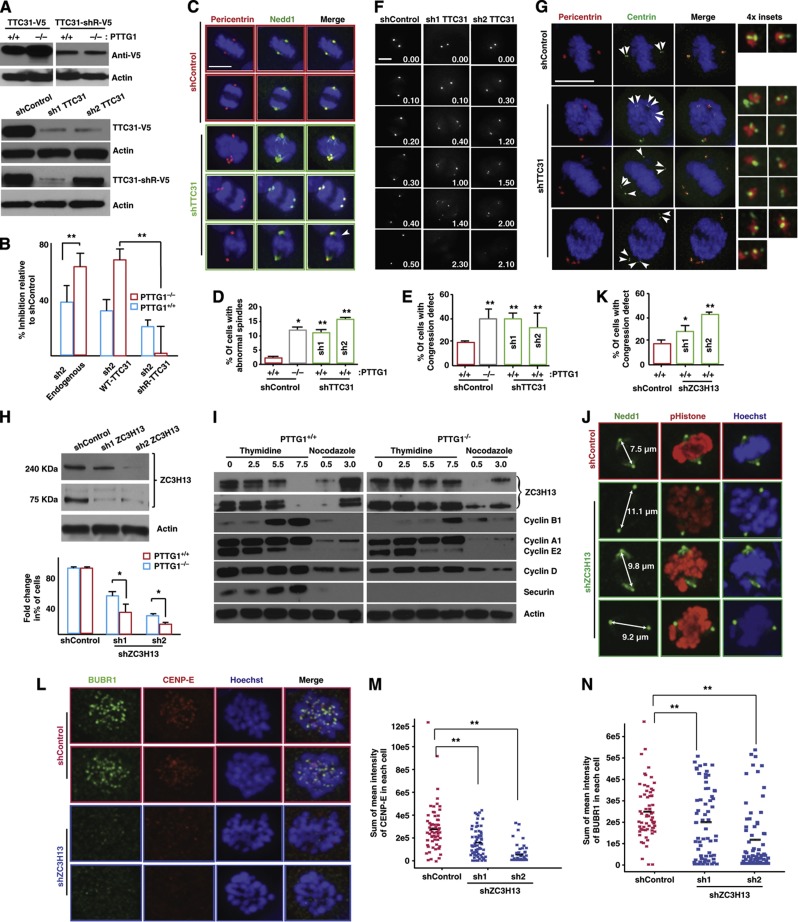
Functional discovery based on genetic interactions. (A) Top panels shows the western blot of total cell lysates expressing both wild-type (TTC31-V5) and shRNA-resistant (TTC31-shR-V5) TTC31 protein tagged with V5 in PTTG1−/− and PTTG1+/+ cell lines. The bottom panel shows the effect of two independent shRNAs in TTC31-V5 and TTC31-shR-V5. TTC31 was knocked down by infecting HCT116 cells with two independent hairpins targeting TTC31, followed by a western blot with anti-V5 antibody to confirm on-target knockdown. (B) Rescue experiment showing the on-target effect of sh2-TTC31 as evaluated by the percentage inhibition in growth WT-TTC31-expressing cells relative to shR-TTC31-expressing cells. (C) Immunofluorescence microscopy images of PTTG1+/+ cells expressing control shLacZ (top) or sh2-TTC31 (bottom). Centrosomes are indicated by pericentrin (red) and NEDD1 (green) staining, and the nucleus was detected with DAPI (blue). Arrowheads indicate lagging chromosomes. (D and E) Quantification of cells with abnormal spindle morphology and cells with congression defects was performed by analyzing at least 100 cells (n=3). **P-value<0.01 calculated using χ2-test. Scale bar, 4 μm. (F) Time-lapse imaging of HeLa cells stably expressing the centrosome marker NEDD1-GFP. Cells were either infected with the negative control shRNA targeting LacZ or with two independent shRNAs against TTC31 (sh1- or sh2-TTC31). Frames taken at the indicated time points (h:min) relative to entry into mitosis are shown. Scale bar, 10 μm. (G) Localization of centrin structures in PTTG1+/+ cells expressing shLacZ control or one of two independent shRNAs against TTC31 (sh1- or sh2-TTC31). DNA and centrosomes were labeled as in C. Representative prometaphase, metaphase and anaphase cells with supernumerary centriole phenotypes are shown. Insets are fourfold magnifications of centrosomal regions. Scale bar, 10 μm. (H) Top panels shows the western blot of total cell lysates expressing two isoforms of ZC3H13 in PTTG1+/+ cells. ZC3H13 was knocked down by infecting HCT116 cells with two independent hairpins (sh1- and sh2-ZC3H13) and followed by western blot with an anti-ZC3H13 antibody (Abcam). The bottom panel shows the negative genetic interaction of two independent shRNAs as assessed by proliferation. (I) Western blot analysis of whole-cell lysates showing the cell cycle-dependant regulation of ZC3H13 in PTTG1−/− and PTTG1+/+ cell lines. The first four lanes represent the time after release from double thymidine block and the last two lanes from thymidine-nocodazole block. The levels of different cyclins fluctuate across different phases of cell cycle and are used as controls. (J) Immunofluorescence microscopy images of PTTG1+/+ cells expressing a negative control shRNA, shRFP (top), or sh2-ZC3H13 (bottom). NEDD1 antibody (green) was used to stain for centrosomes and phosphohistone H3 antibody (red) to stain for mitotic cells. Nuclei were stained with Hoechst stain (blue). The distances between the poles are shown for representative cells. (K) Quantitation of chromosome congression defects in control as well as cells following ZC3H13 knockdown from two independent experiments. A minimum of 30 cells were counted in each case. *P<0.01, Student's t-test. (L) Immunofluorescence microscopy of spindle checkpoint proteins CENP-E and BUBR1 in PTTG1+/+ cells expressing the control shRFP (top) or sh2-ZC3H13 (bottom). Cells were stained with BUBR1 antibody (green) and CENP-E antibodies (red). Nuclei were stained with Hoechst stain (blue). (M and N) Quantitation of localization defect of spindle checkpoint proteins, measured as the sum of mean fluorescence intensity of BUBR1 or CENP-E in each cell. The aggregate results from two independently infected cell populations are shown with either shControl, sh1-ZC3H13 or sh2-ZC3H13. Thirty to 50 cells were counted in each case. **P<0.001, **P<0.01 by Student's t-test.